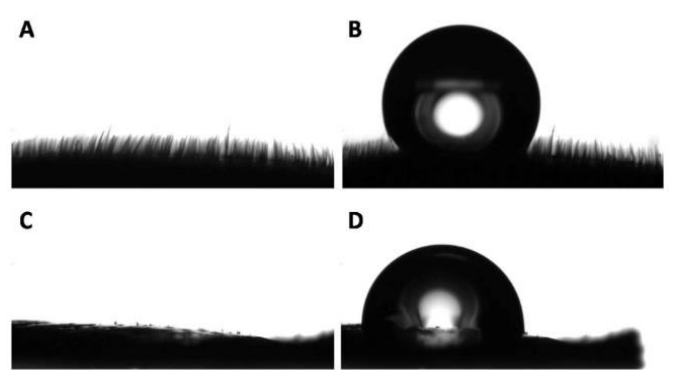
Figure 10. Representative side view of the white and black surfaces. ( A ) Profile of the white part of a G. orientalis elytron and ( B ) water droplet deposited on its surface. ( C ) Profile of the black part of a G. orientalis elytron and ( D ) water droplet deposited on its surface [55].